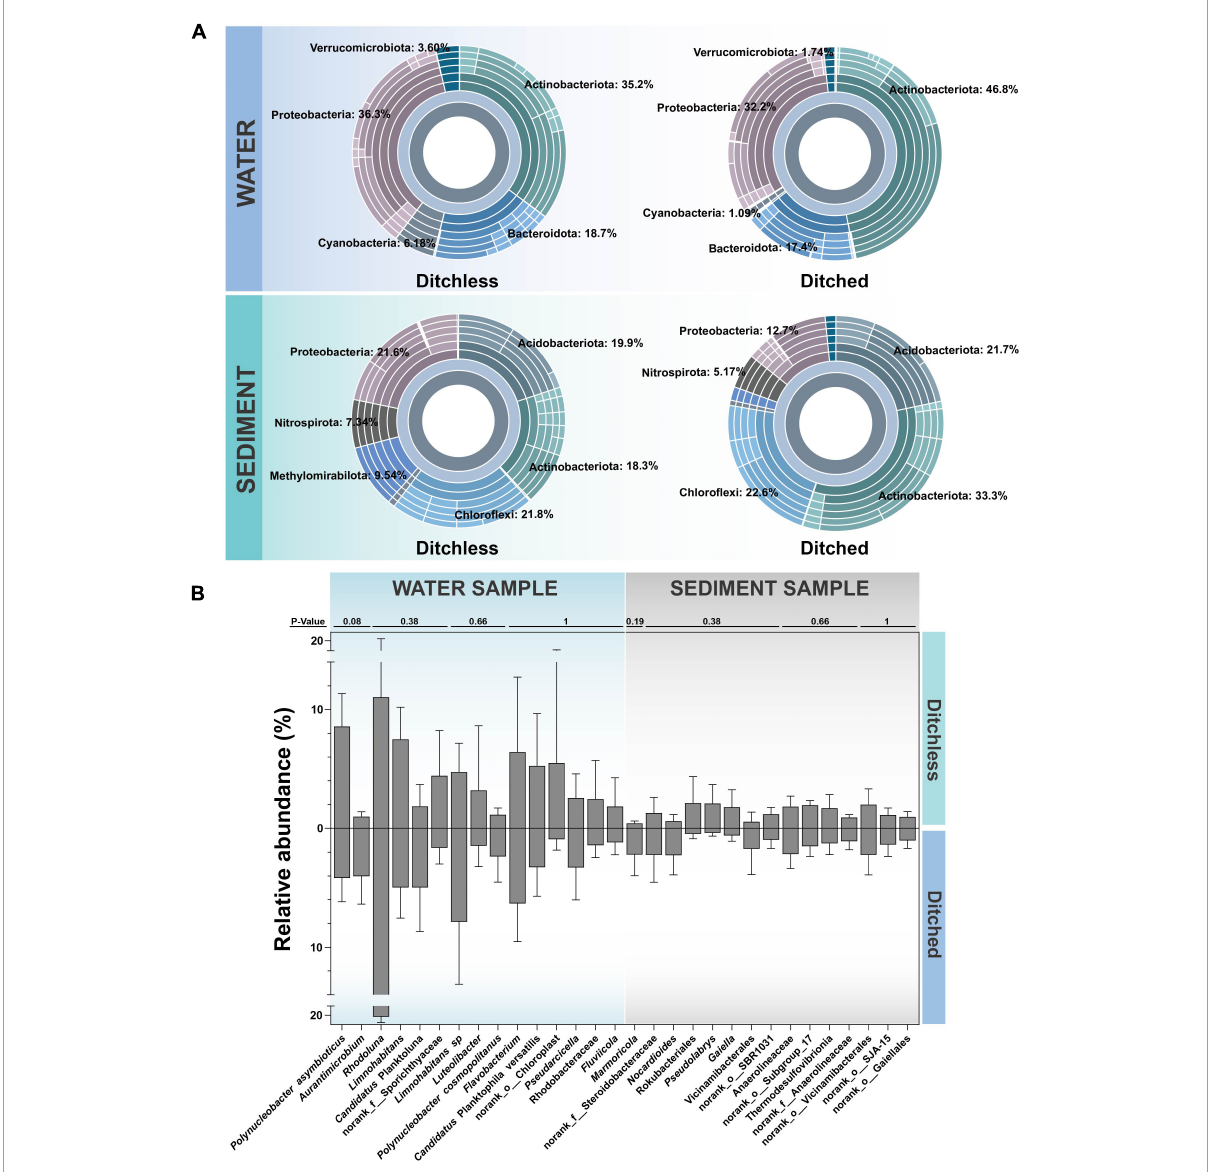
FIGURE3 Bacterial community structures of the water and the sediment samples in the ditched and the ditchless systems. (A) Sunburst plots of the most abundant phyla. (B) The 15 most abundant OTUs. All data are expressed as the mean ± s.d. The difference test was completed by the Wilcoxon rank sum